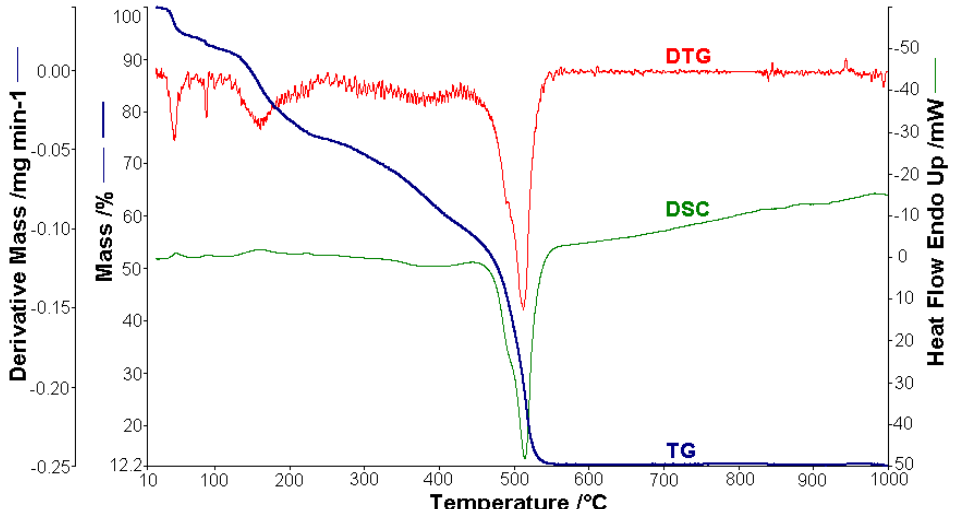
Figure 5. Thermoanalytical curves of [NiL 2 ] ∙ H 2 O.